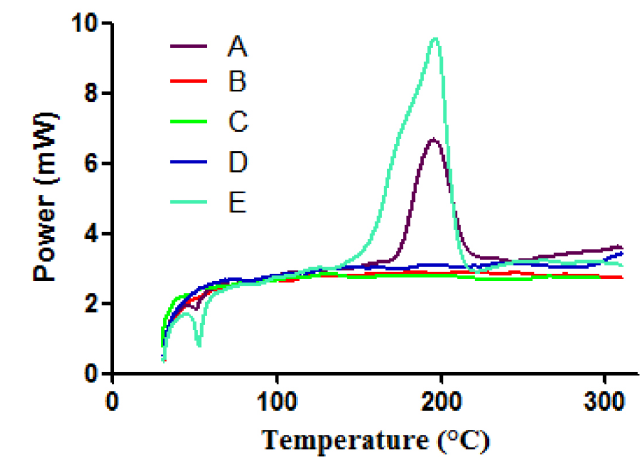
FIGURE 3 - DSC curves of gelatin/chitosan/PEG mixture (A) gelatin/chitosan films (B), chitosan (C), gelatin (D) and PEG